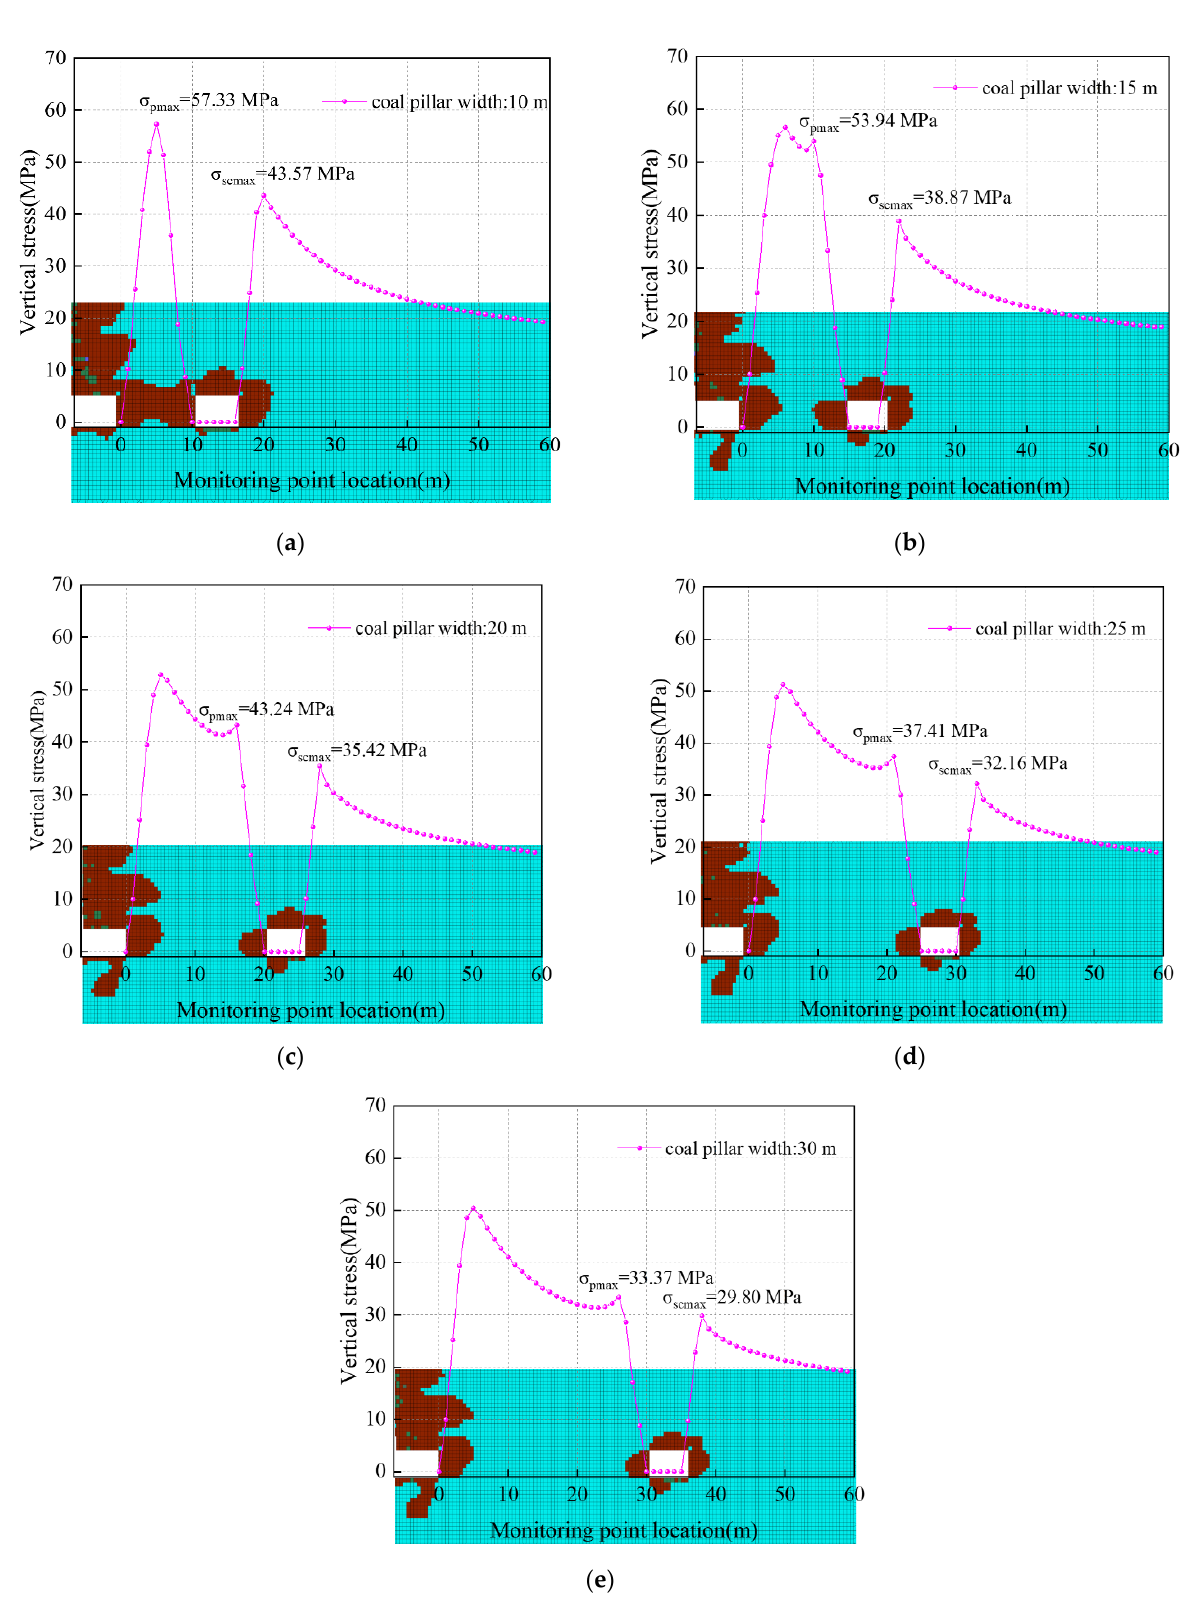
Figure 12. Stress and plastic area of surrounding rock under different widths of coal pillars: ( a ) The width of the coal pillar is 10 m; ( b ) The width of the coal pillar is 15 m; ( c ) The width of the coal pillar is 20 m; ( d ) The width of coal pillar is 25 m; ( e ) The width of coal pillar is 30 m.